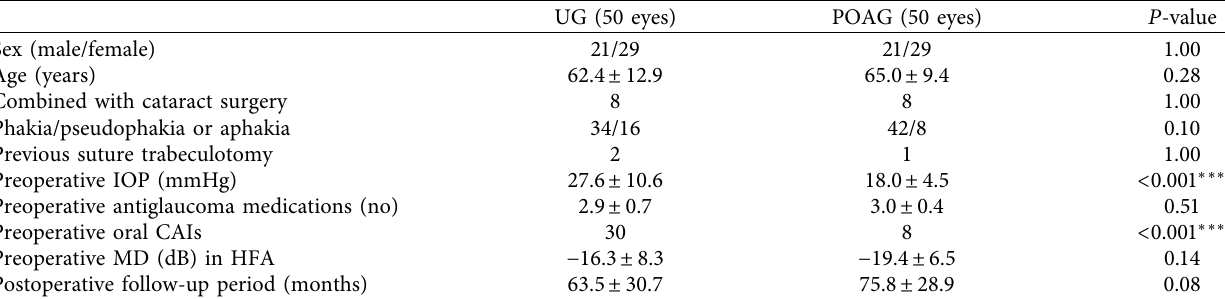
Table 1: Baseline patient characteristics